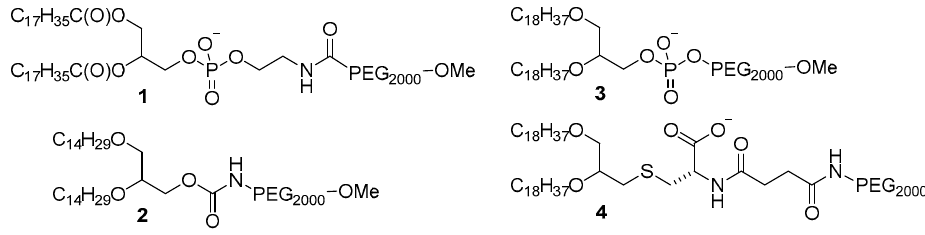
Figure 1. Chemical structure of PEG-containing glycerolipids.